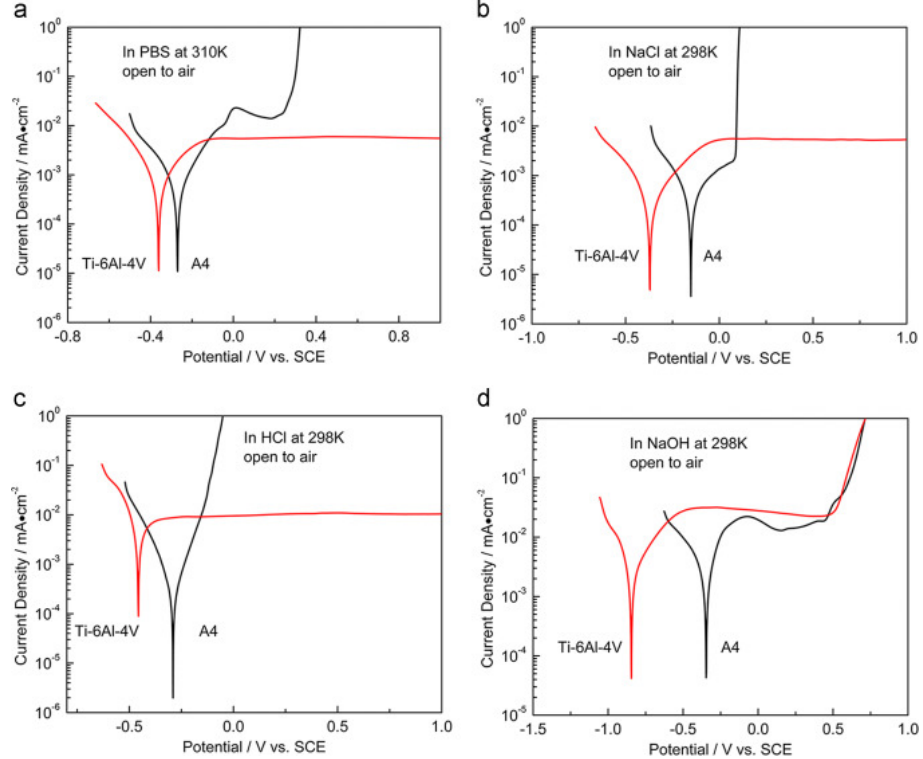
Figure 13. Potentiodynamic polarization curves of BMG and the Ti–6Al–4V alloy in ( a ) PBS, ( b ) 0.9 wt % NaCl, ( c ) 1 mol/L HCl, and ( d ) 1 mol/L NaOH solutions. Reproduced with permission from [110]. Copyright 2015,